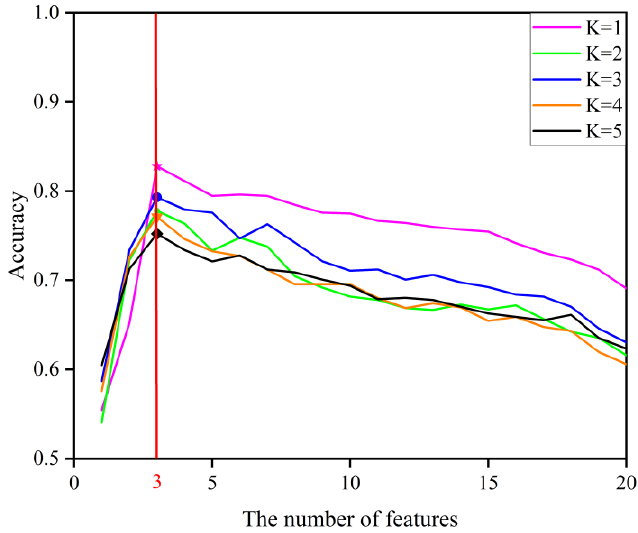
Figure 8. Selected features using sequential floating forward selection algorithm.